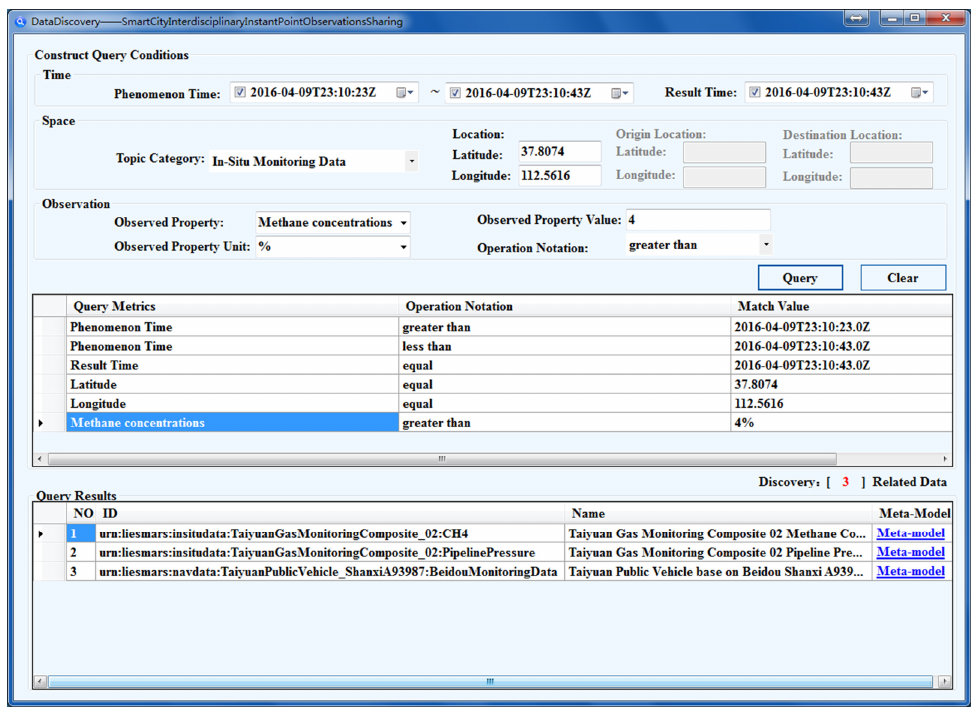
Figure 9. Data discovery of interdisciplinary instant point observation data for the gas leak emergency response.